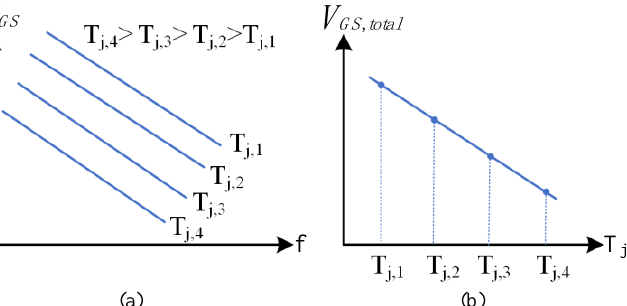
Figure 3. Methodology of the proposed technique to establish T j from chirp signals. ( a ) V GS vs. f ; ( b ) V GS , total vs. T j .